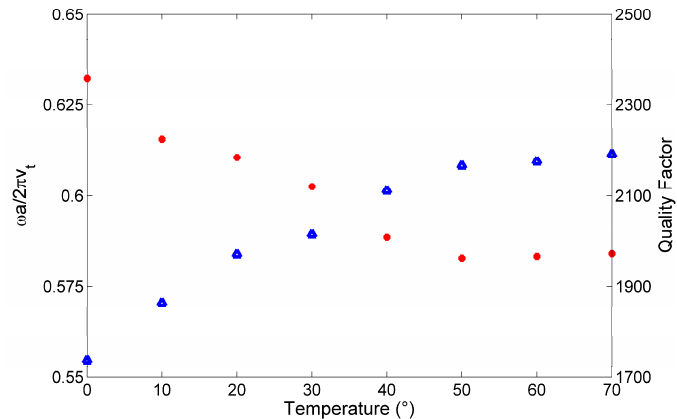
Figure 9. Varied frequencies ( blue triangular dots ) and corresponding quality factors ( red circle dots ) of the second liquid compressional mode by tuning the temperature of water in the holes. The geometric parameters are h/a = 0.4, r/a = 0.39, r i /a = 0.1, h w /h = 1, l/a = 0.1.